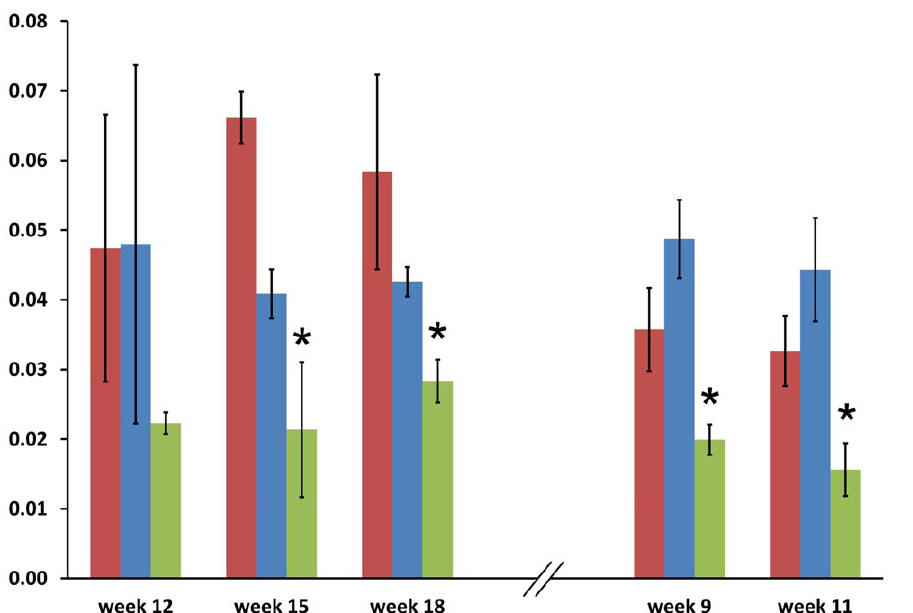
Figure 2. Total phosphoglucomutase activity. The bar chart represents the differences between potato cultivars in respect to total phosphoglucomutase activity (the unit is A340/min). Left side of the hatched bars: 2008; right side: 2009. Significant differences (p-value , 0.05) between Kuras and two other cultivars are indicated with asterisks. Desiree is shown in red, Jutlandia in blue and Kuras in green. The error bars indicate standard error of measurement.